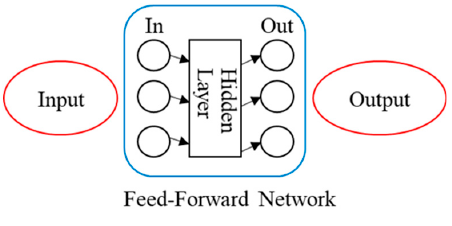
Figure 9. Basic structure of the CNN model.